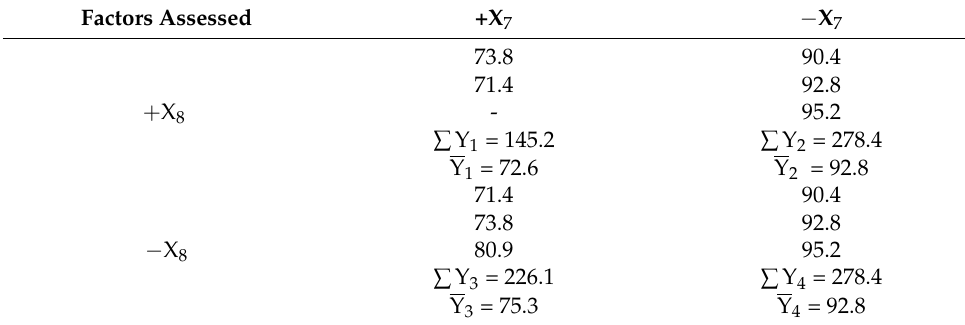
Table 4. Table for calculating the effects of factors.